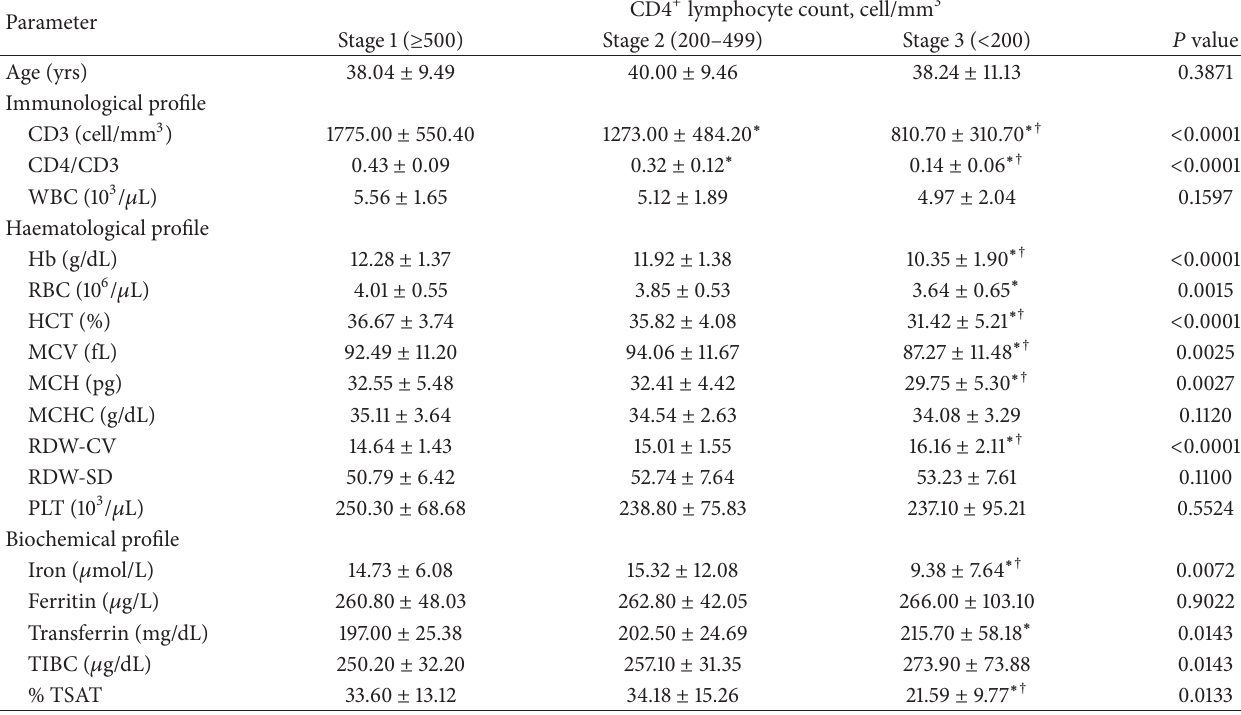
Table 5: Immunological, haematological, and biochemical profiles of the study population stratified by disease stage.